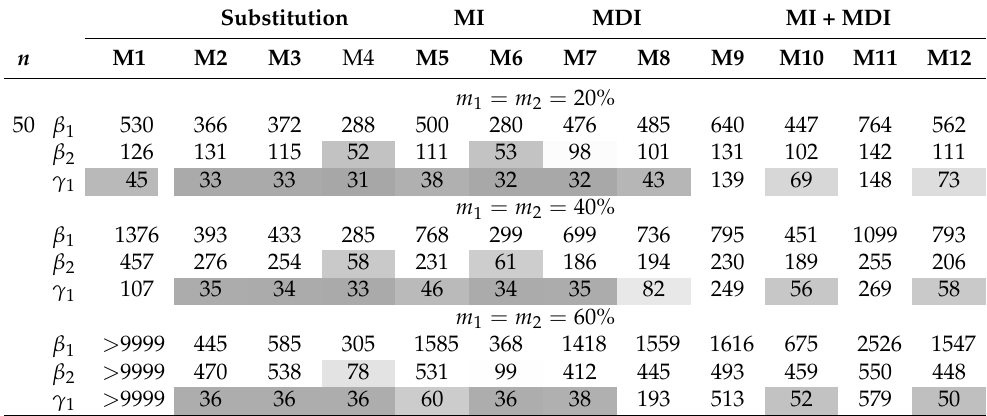
Table 2. Summary of the MSE ( × 1000) when covariates are independent and X ∗ to lower LOD. M1 is complete-case analysis; M2–M4 are the different variants of the substitution methods; M5–M6 are the different variants of the MI methods; M7–M8 are the different variants of the MDI methods; M9–M12 are the different variants of MDI-embedded MI (MI + MDI) methods. MSEs less than 0.1 are highlighted in gray, with darker tones corresponding to smaller